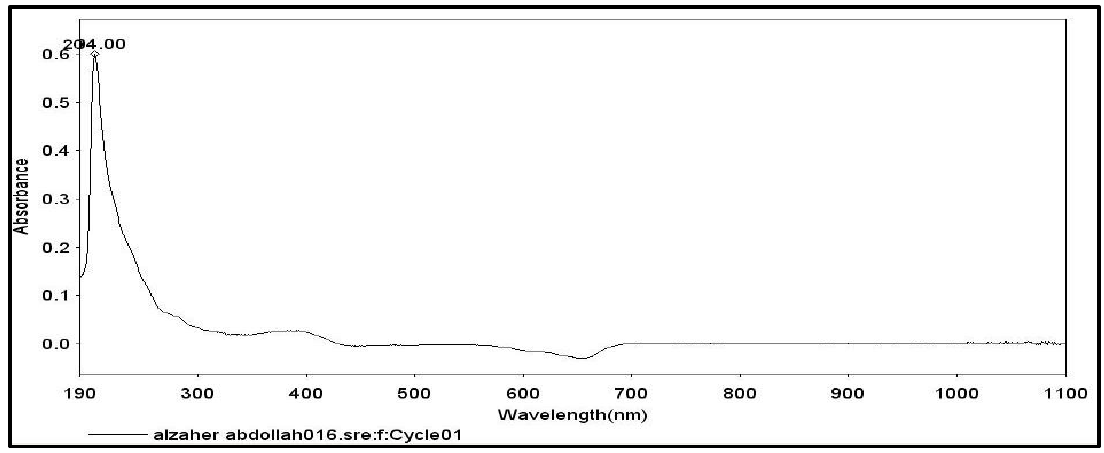
Figure 14. The ʎ max spectrum for compound C The major absorption maxima are 201 which is the same that also observed for chelidonine at 204.